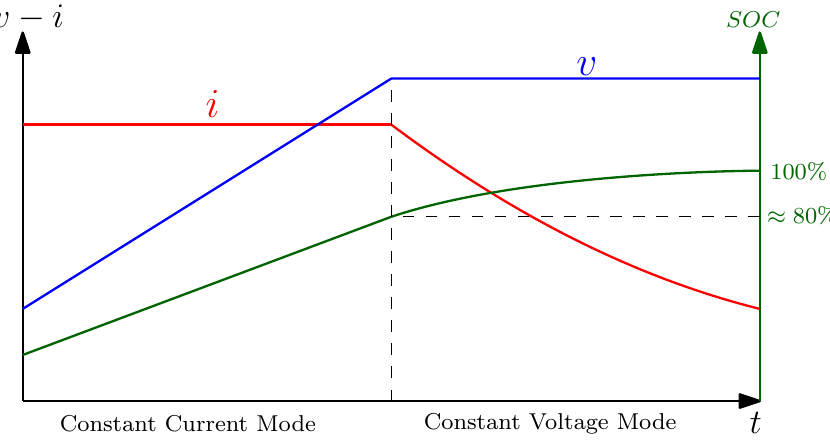
Figure 2. The typical CCCV charging